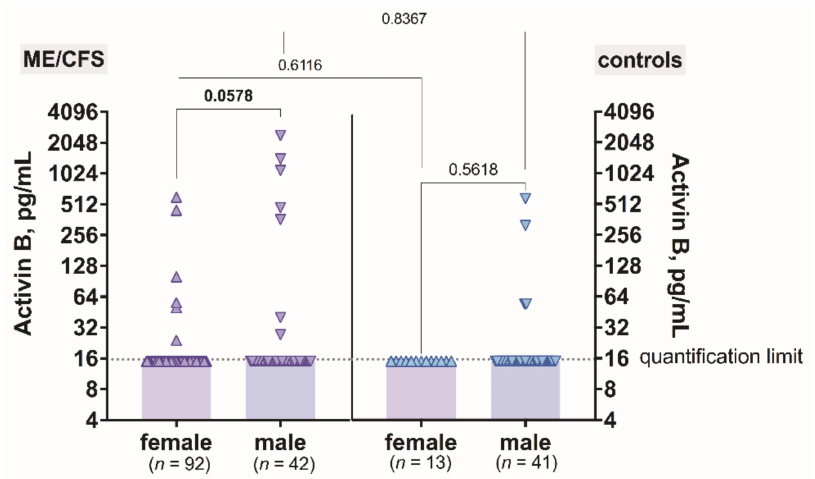
Figure 2. The levels of activin B in patients with ME/CFS and controls plotted against gender. The level of activin B plotted against age did show that activin B level does not change regarding the aging process of patients with ME/CFS and also controls (Figure 3).